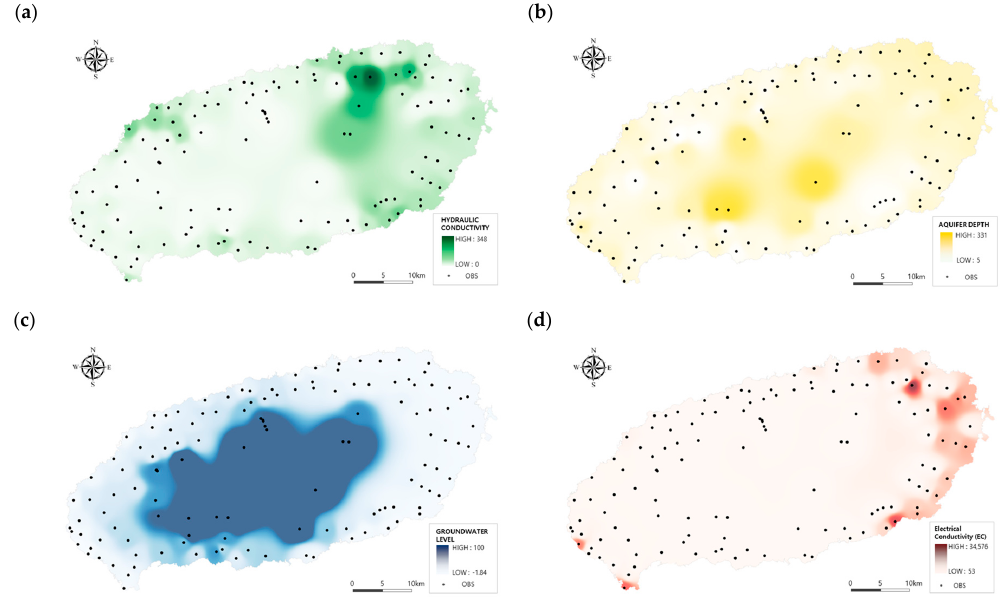
Figure 4. Spatial mapping of GALDIT parameters for ( a ) hydraulic conductivity, ( b ) aquifer depth, ( c ) groundwater level above sea, and ( d ) electric conductivity.